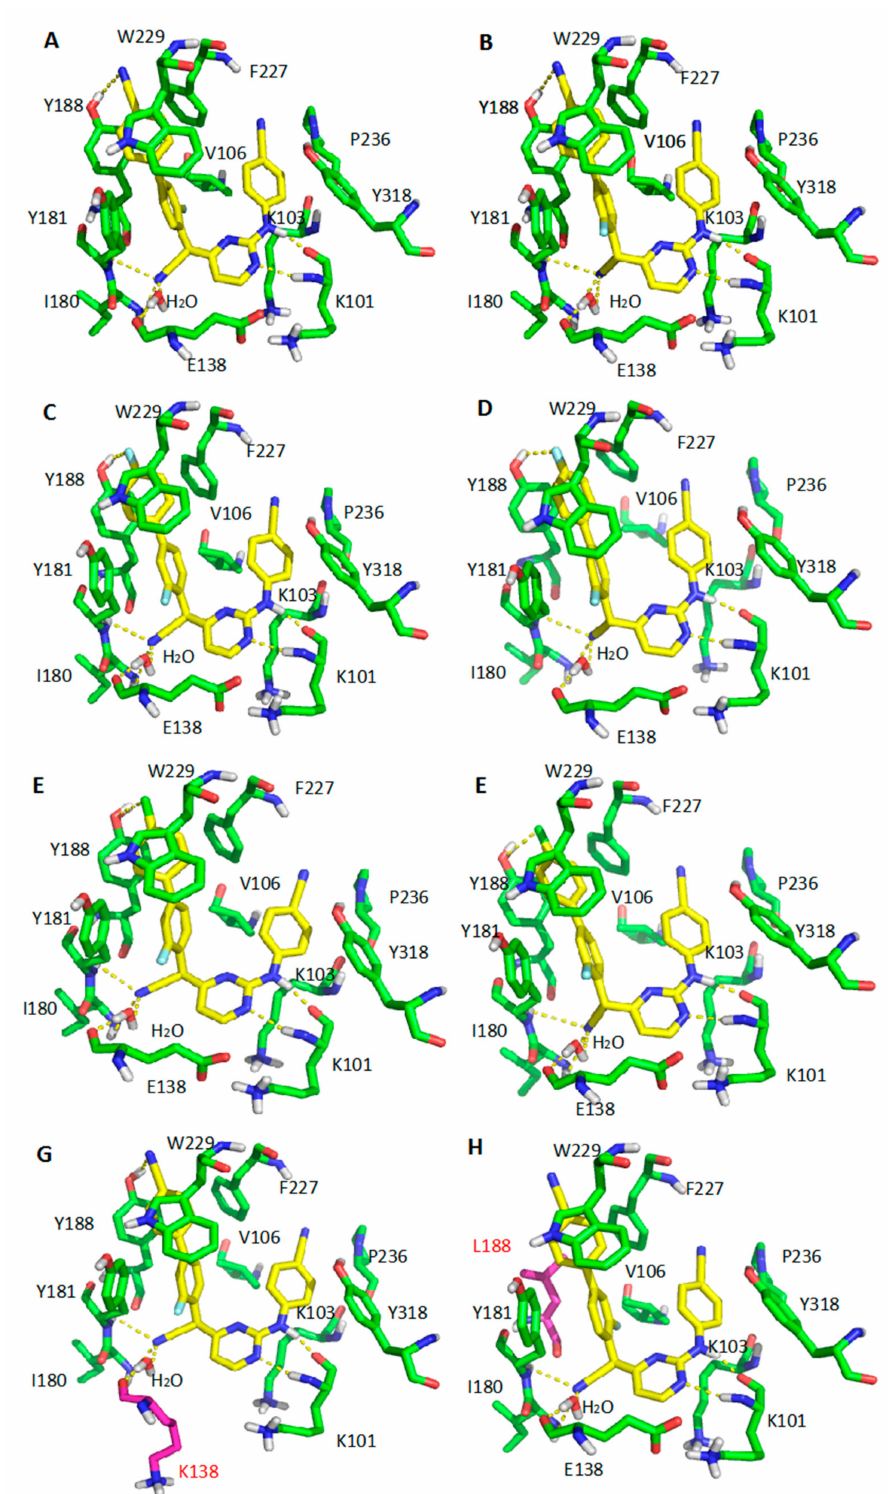
Figure 4. Predicted binding modes of 10l , 10o , and 10p (carbons in yellow) with the HIV-1 WT, E138K, and Y188L mutant RT (PDB: 2ZD1). ( A ) RT with 10p - S ; ( B ) RT with 10p - R ; ( C ) RT with 10l- S ; ( D ) RT with 10l- R ; ( E ) RT with 10o - S ; ( F ) RT with 10o - R ; ( G ) E138K mutant RT with 10p - S ; ( H ) Y188L mutant RT with 10p - S . Residues involved in interactions are shown as green sticks. Mutated residues are depicted as purple sticks. Hydrogen bonds are depicted as yellow dashed